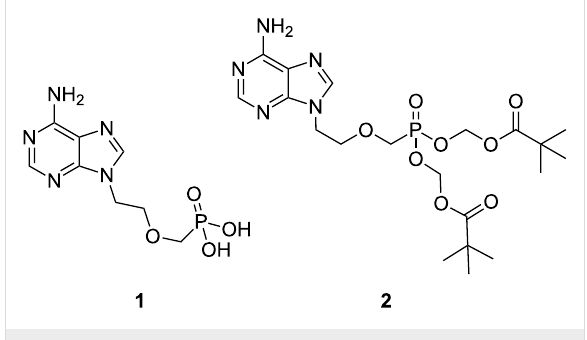
Figure 1: Adefovir ( 1 ) and its prodrug 2